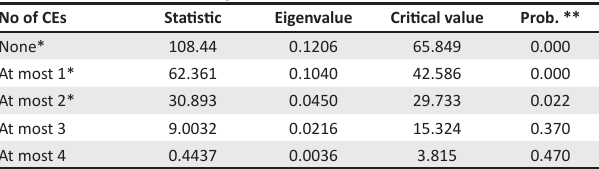
TABLE 5: Pooled mean group estimation results (Boone) – (2004–2018). D.fii Coefficient Std. error